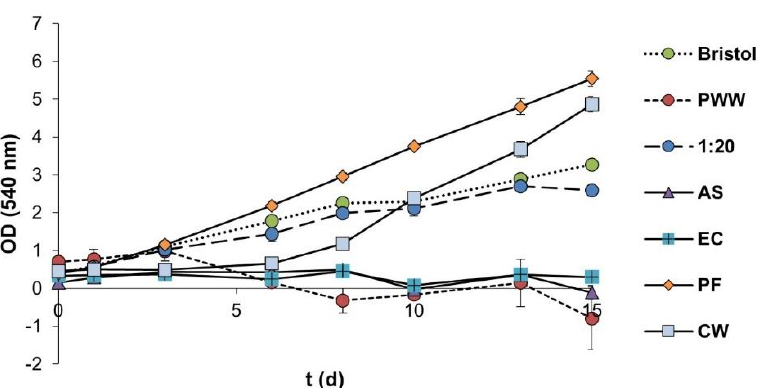
Figure 5. Growth curves for Tetradesmus obliquus cultivated in the pretreated piggery wastewaters: AS — ammonia stripping, EC — electrocoagulation, PF — photo-Fenton, and CW — constructed wet- lands. Bristol medium, untreated PWW, and diluted (1:20) effluents were used for comparison. Values are presented as the mean ± mean deviation ( n = 2).